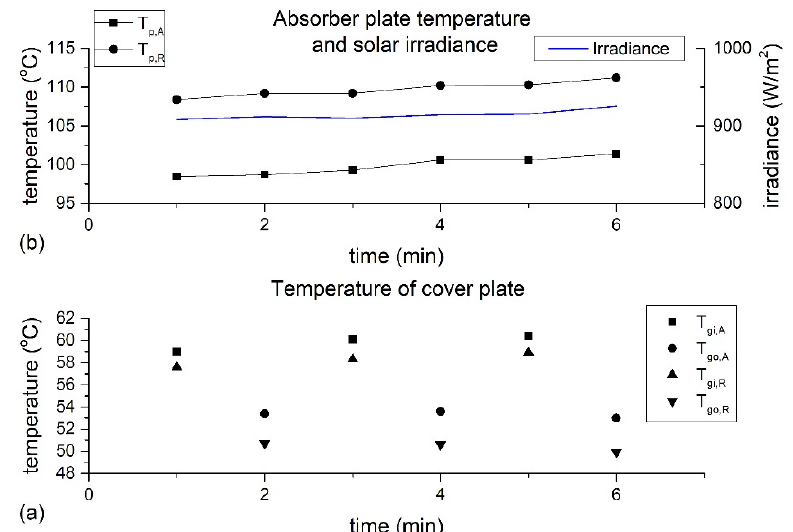
Figure 8. A short steady state of the solar collector in a heat collecting process when the solar irradiance was about 915 W/m 2 and the ambient temperature was 33 °C: ( a ) the temperature of cover plate; ( b ) the absorber plate temperature and solar irradiance.